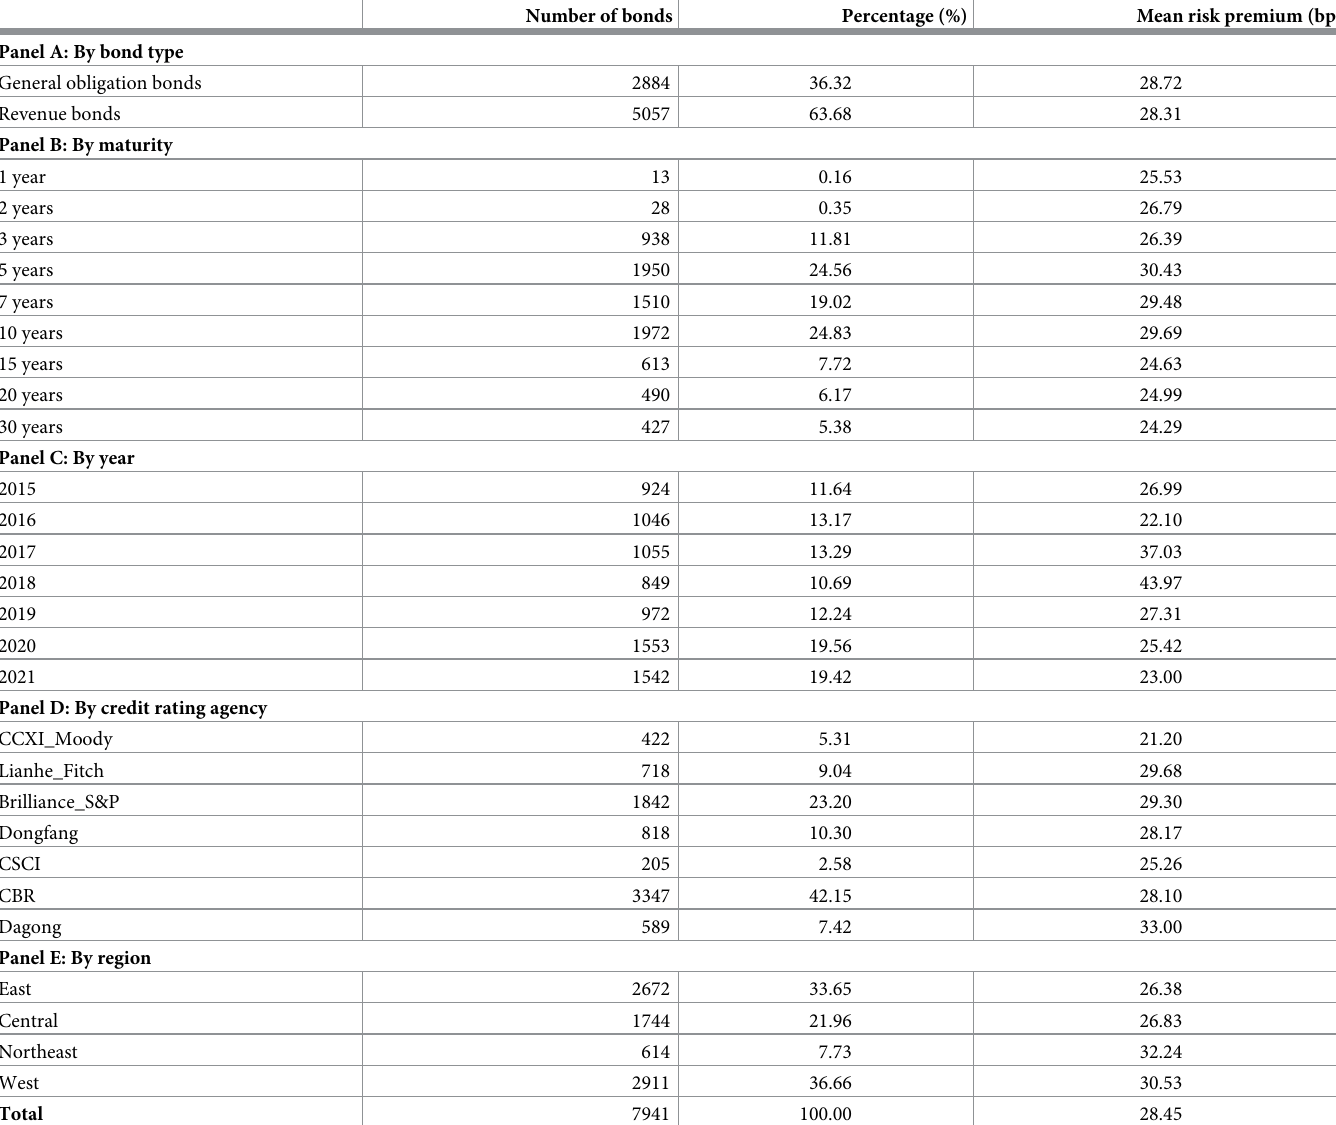
Table 3. Distribution of sample. This table reports the distribution of the sample bond observations by bond type, maturity, year, credit rating agency, and region. The percentage (%) is calculated as the number of bond issuances assigned to each breakdown category divided by the total number of 7941